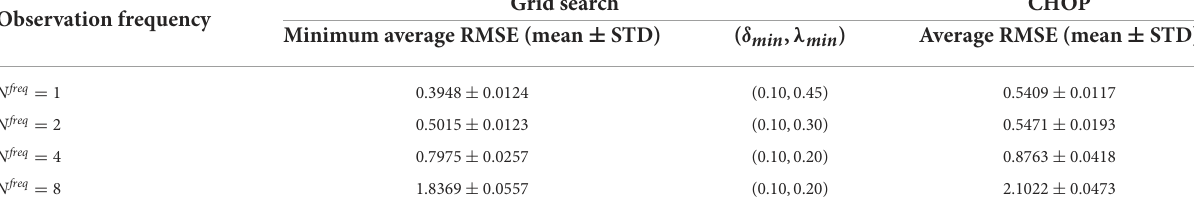
TABLE 3 As in Table 1, but for performance comparison between the grid search method and the CHOP workflow in the half observation scenario ( 1 n = 2), with the same ensemble size N e = 30 yet different observation frequencies. Grid Observation frequency